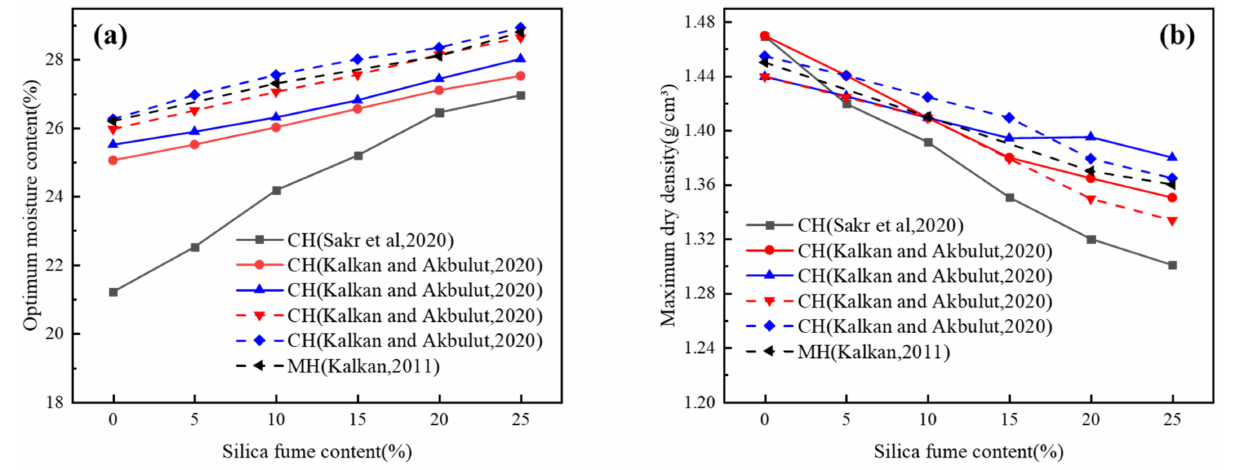
Figure 9. Compaction characteristics of expansive soil stabilized by silica fume: ( a ) optimum moisture content; ( b ) maximum dry density. Adapted from